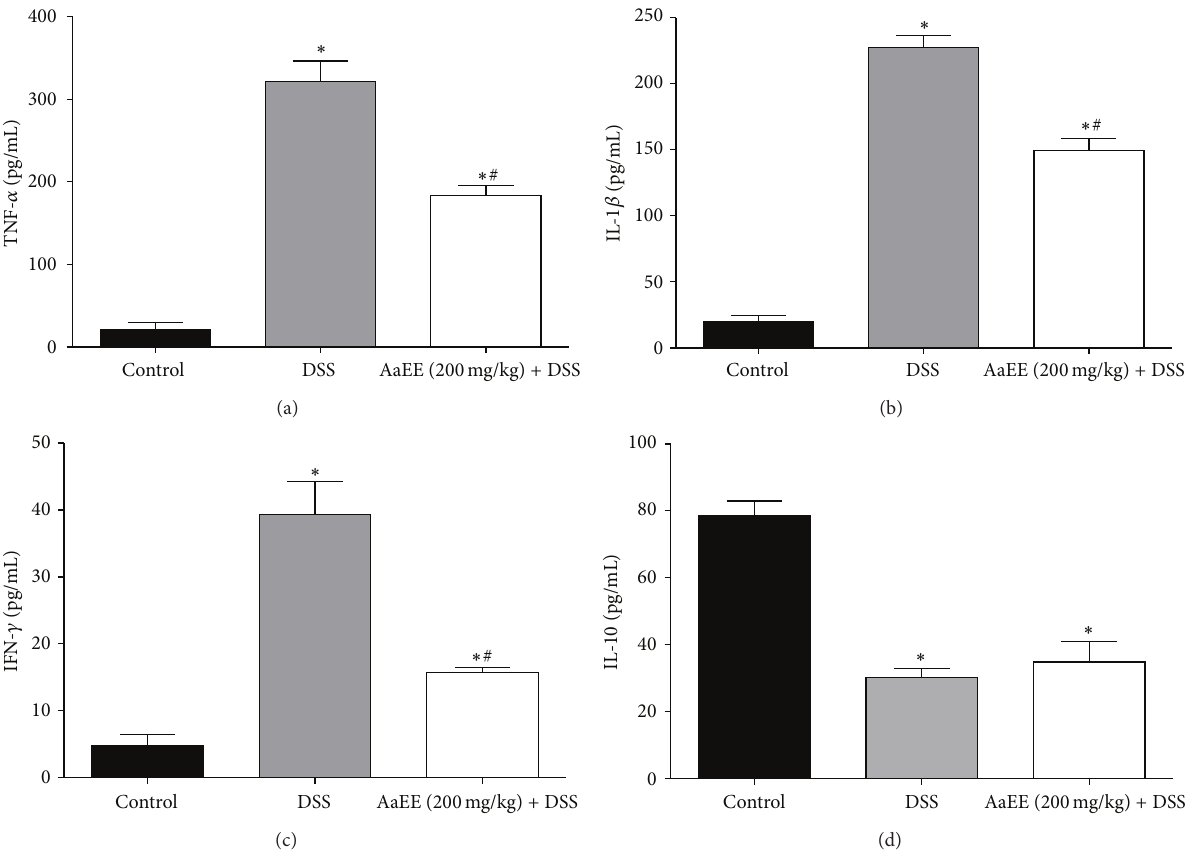
Figure 5: Effect of AaEE on cytokines in DSS-induced colitis. TNF- 𝛼 (a), IFN- 𝛾 (b), IL-1 𝛽 (c), and IL-10 (d) concentration in the plasma of mice from all groups. AaEE reduces the systemic levels of TNF- 𝛼 , IFN- 𝛾 , and IL-1 𝛽 and there were no significant differences on the levels reported for the IL-10 between the DSS group and the group of AaEE. All results are expressed as the mean ± SD. ∗ 𝑃 < 0.05 versus control; # 𝑃 < 0.05 versus DSS